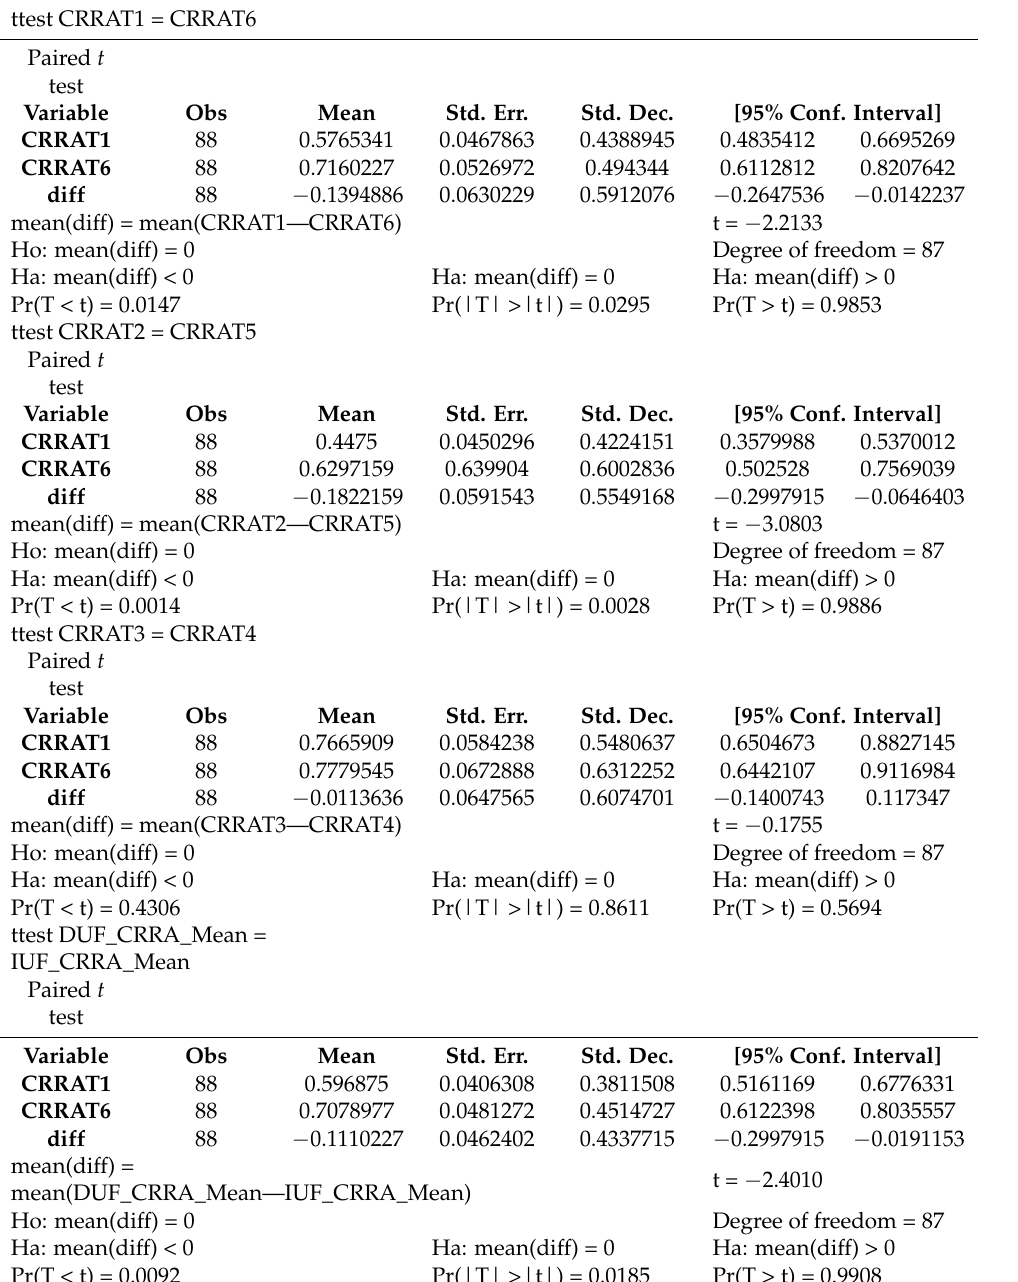
Table A6. Results of two-sample T test for paired data (using mid-point CRRA’s).